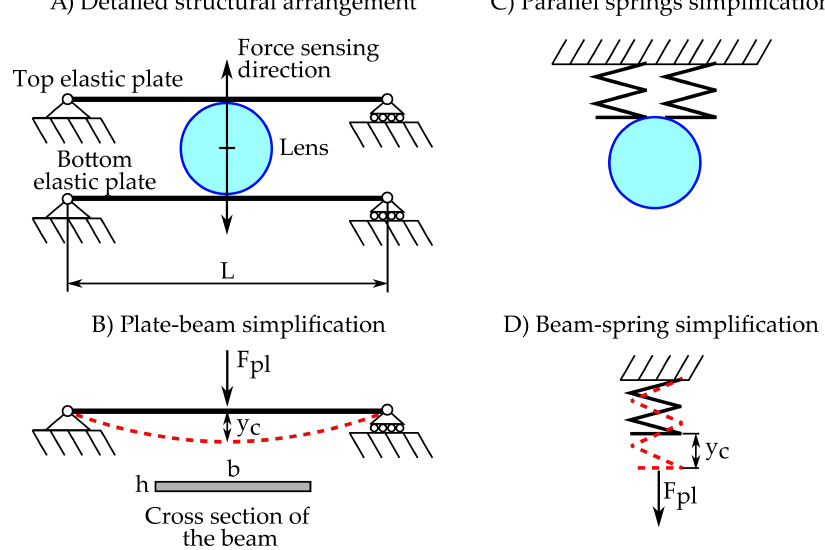
Figure 4. ( A ) proposed architecture to associate the lens displacement with the force to be measured; ( B ) beam to be solved to estimate the behavior of the elastic plate and the beam’s cross section; ( C ) both plates can be simplified to a parallel spring association; ( D ) spring equivalent to the beam shown in